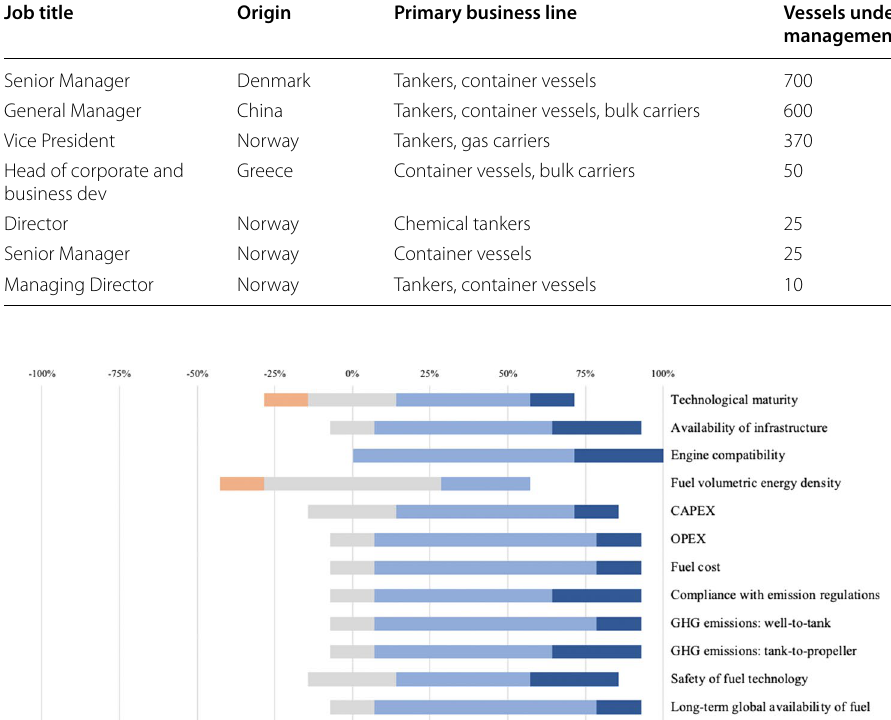
Table 3 Overview of survey participants